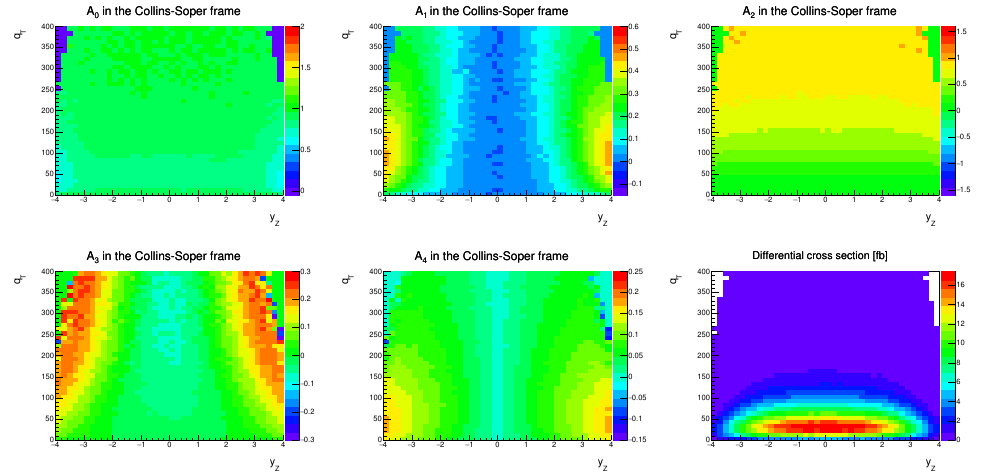
2 l 2 (cid:23) production. !